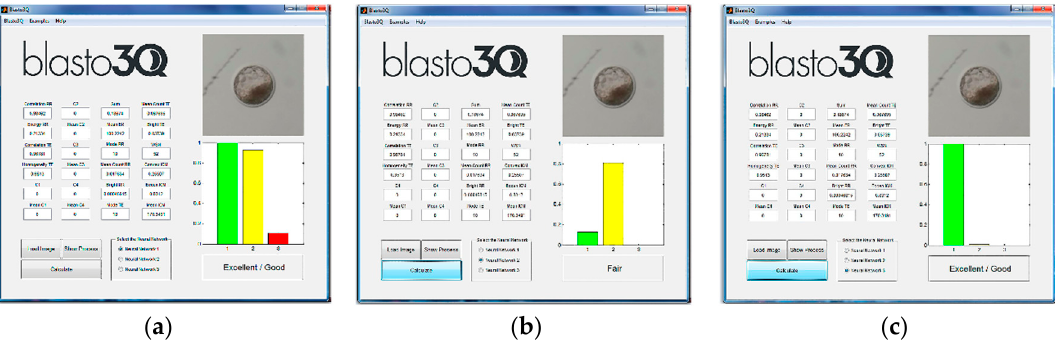
Figure 4. Different graphic interfaces after analyzing the same uploaded blastocyst image from a smartphone source. The mode of the results graded the embryo as ( a , c ) “excellent/good”, although ( b ) one Artificial Neural Network (ANN) produced an alternative result (“fair”).